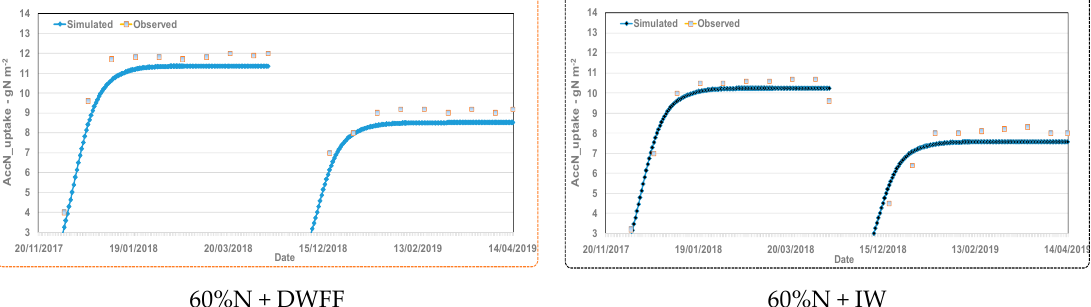
Table 8. Effect of water quality and nitrogen fertigation on the average weight of barley dry matter and compares it to simulated barley dry matter for all treatments. Observed Dry Treatments